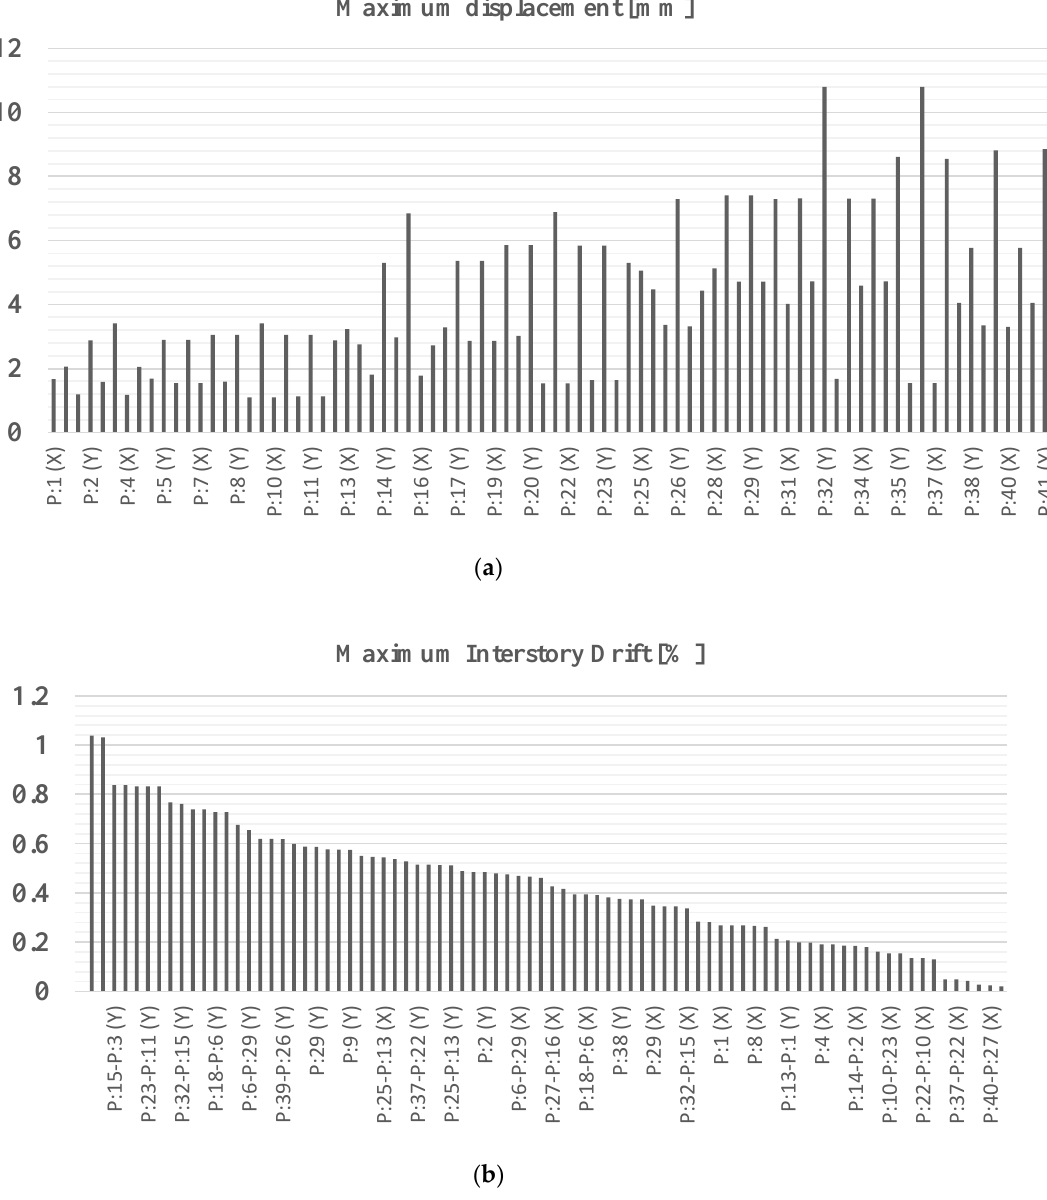
Figure 23. Structure B, Test 2, seismic action 2: ( a ) maximum displacement; ( b ) maximum interstory drift %.